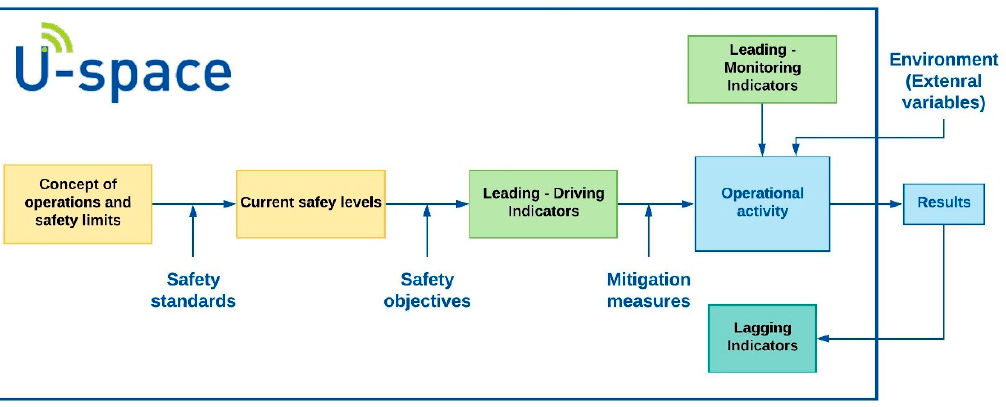
Figure 2. Current U-space safety framework.